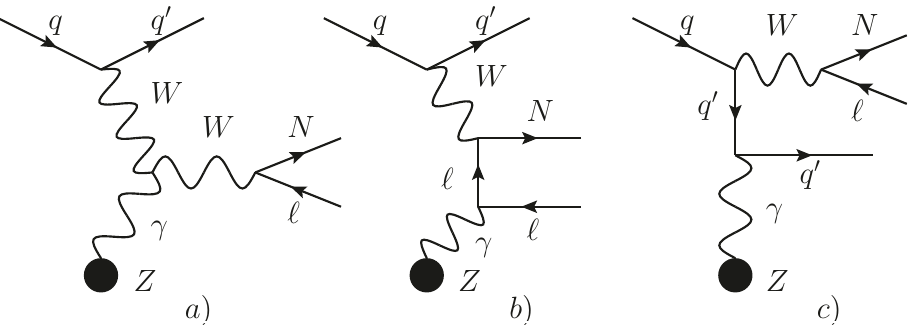
Figure 9 . Combination x 2 f ( x ) used in eq. (2.13) for quark and gluon PDFs (for p s The functions peak at small values of x and therefore a probability of the centre-of-mass energy of the parton pair close to p s is small.